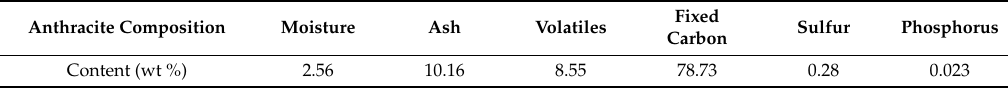
Table 2. Major element compositions of anthracite from Yangquan in Shanxi province.